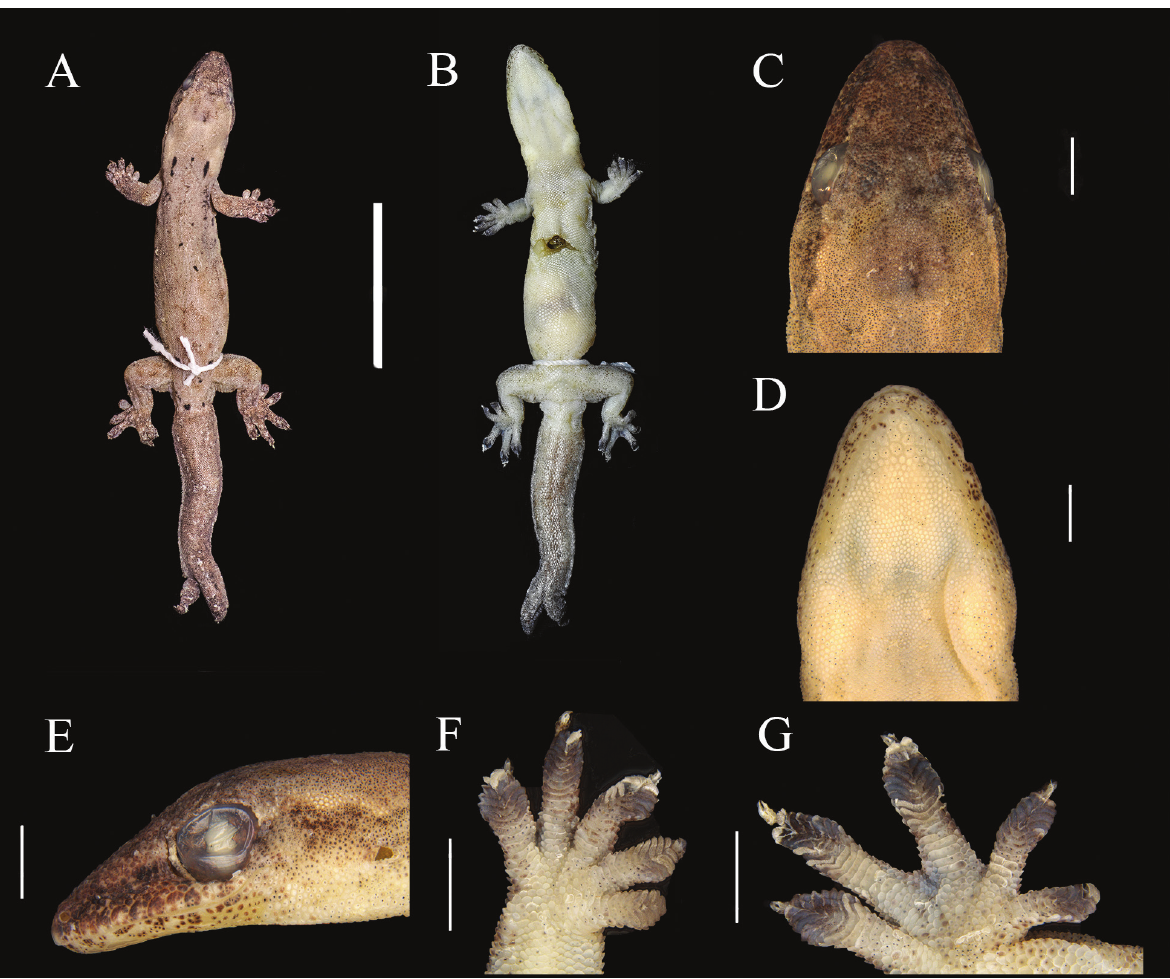
Figure 3. Morphological features of specimen SYNU210417 in preservative. A. Dorsal view of entire body; B. Ventral view of entire body; C. Dorsal view of head; D. Ventral view of head; E. left head; F. right hand; G. right foot. Scale bars: 2cm ( A, B ); 2mm ( C–G